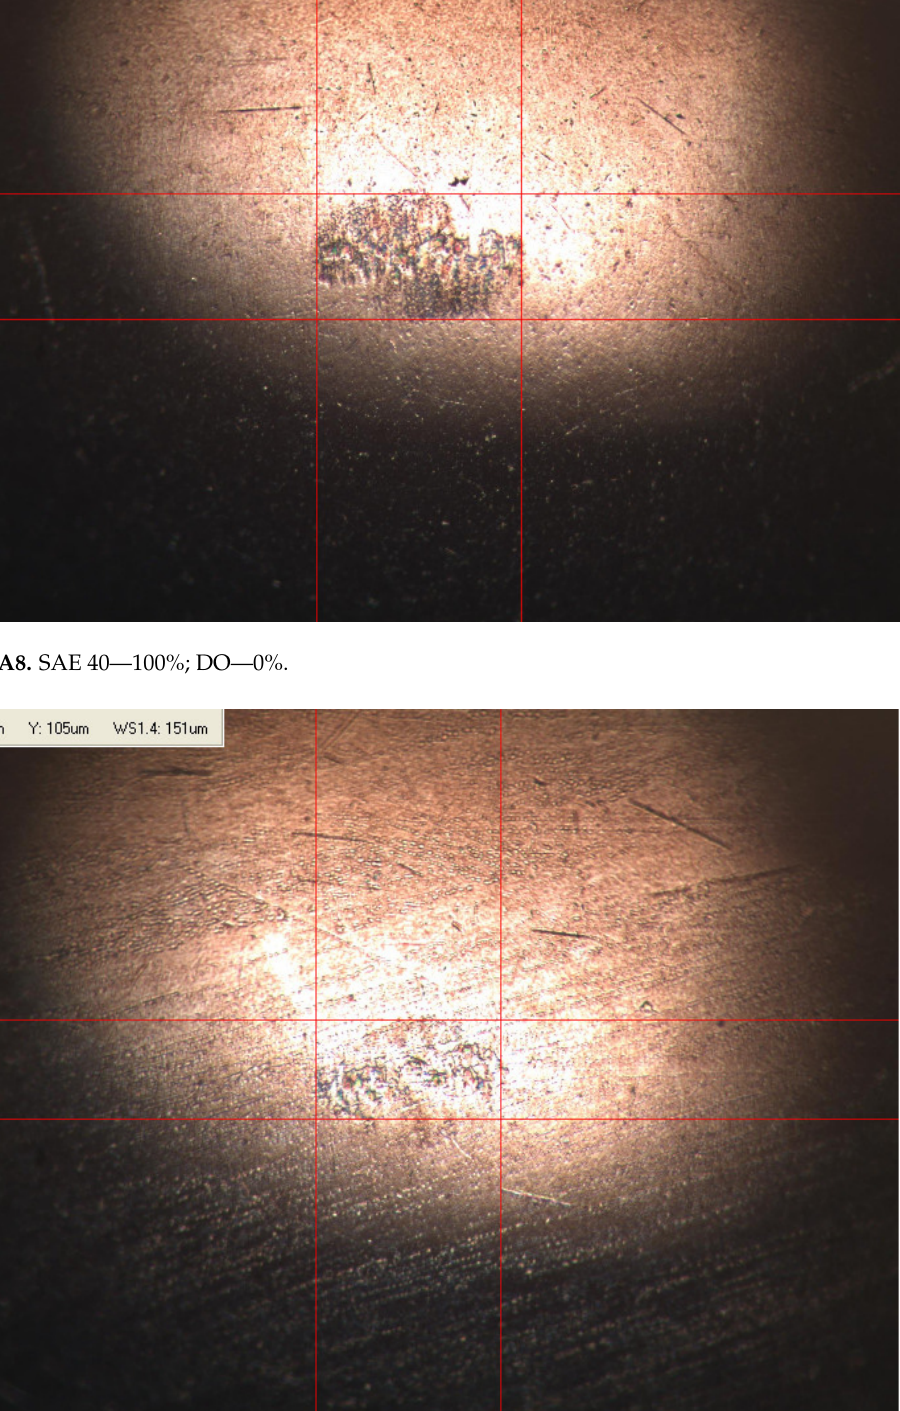
Figure A9. SAE 40—99% m/m; DO—1% m/m.